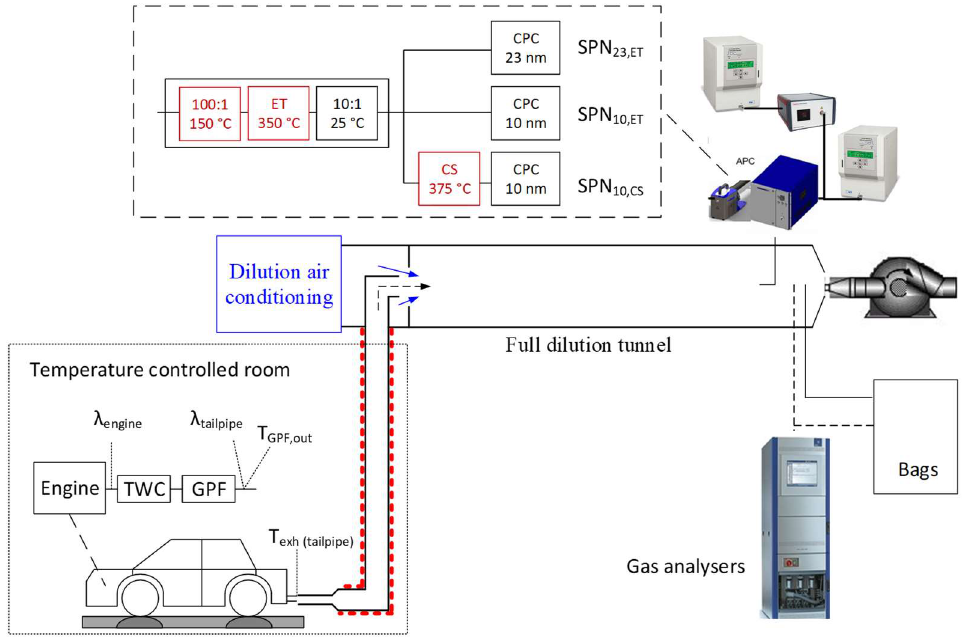
Figure 7. Schematic setup. CPC = condensation particle counter; CS = catalytic stripper; ET = evaporation tube; GPF = gasoline particulate filter; TWC = three-way catalyst.